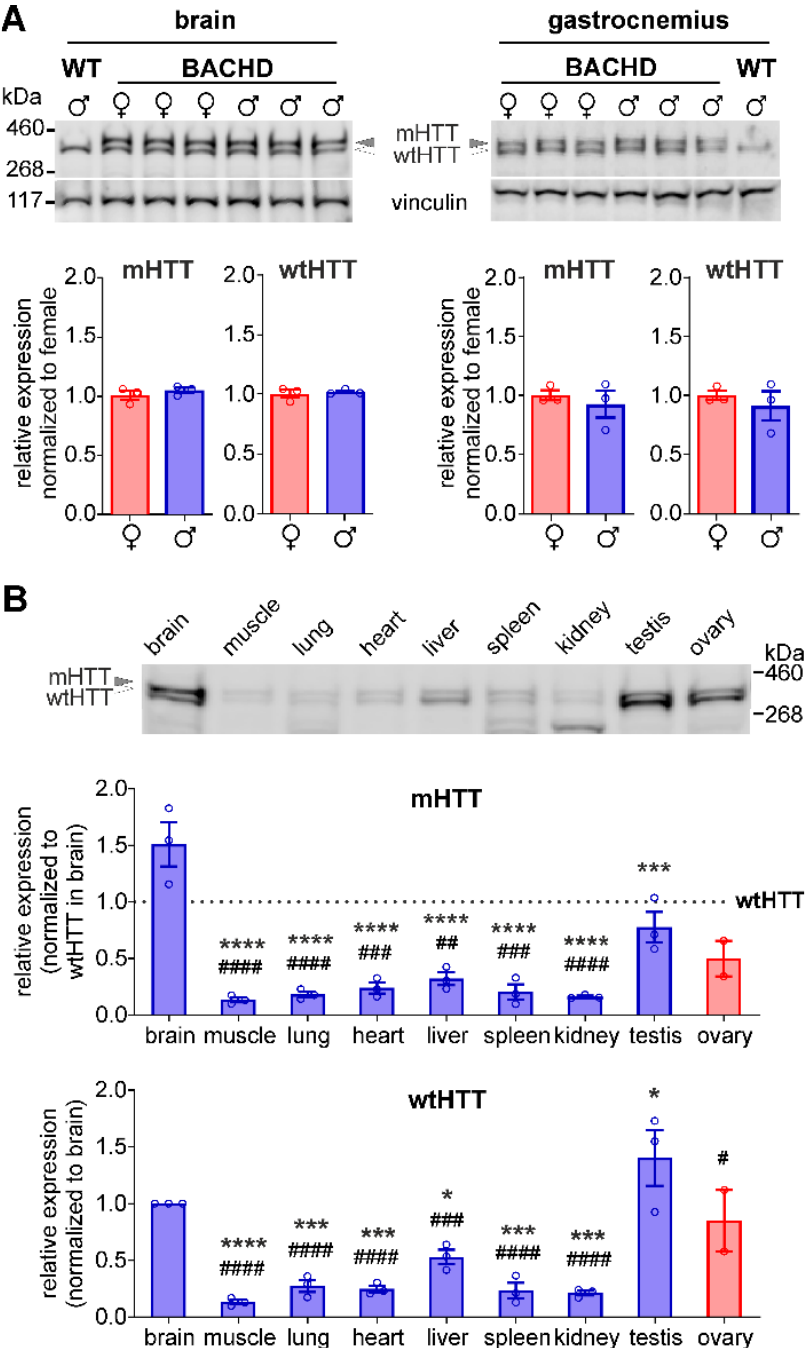
Figure 5. Comparisons of mHTT and wtHTT expression in females vs. males and in brain vs. other organs in the middle-aged group of BACHD rats (7 months). ( A ) Representative western blot and quantification of mHTT and wtHTT expression in the brain (left) and in the gastrocnemius muscle (right) normalized to vinculin ( n = 3/genotype, Student’s t -test for each tissue). Values of mHTT and wtHTT normalized to vinculin were compared between female and male BACHD rats in brain and muscle tissue. ( B ) The expression levels of mHTT and wtHTT were compared between brain, muscle, lung, heart, liver, spleen, kidney and testis in adult male rats ( n = 3/tissue), as well as between testis and ovary ( n = 2 females and 3 males). 30 μg protein samples from each tissue type were loaded into the gel. Membranes were incubated with SYPRO Ruby Protein Blot Stain to detect total